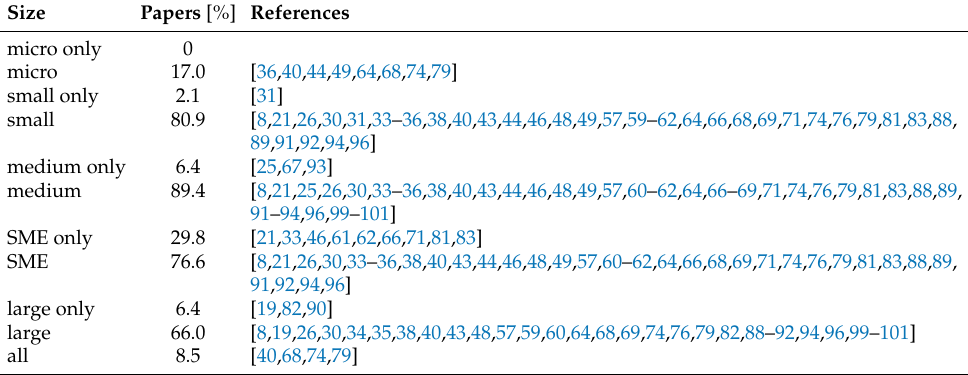
Table 6. Papers’ coverage of company sizes.